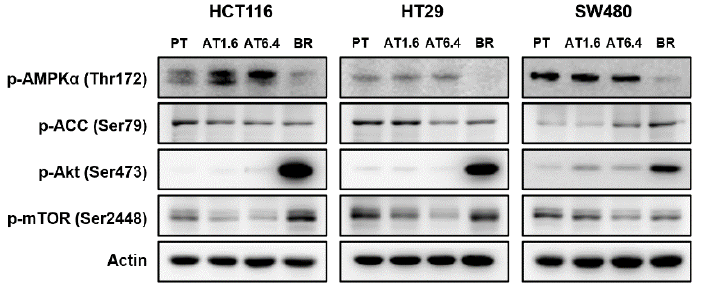
Figure 5. Effects of butyrate resistance on AMPK/ACC and Akt/mTOR signaling in the parental